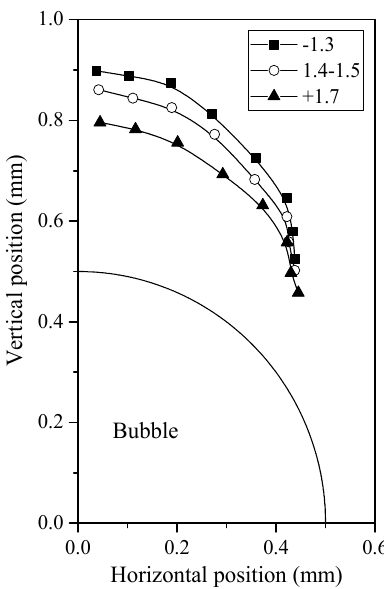
Figure 10. Boundary of coal sample resistance layer.